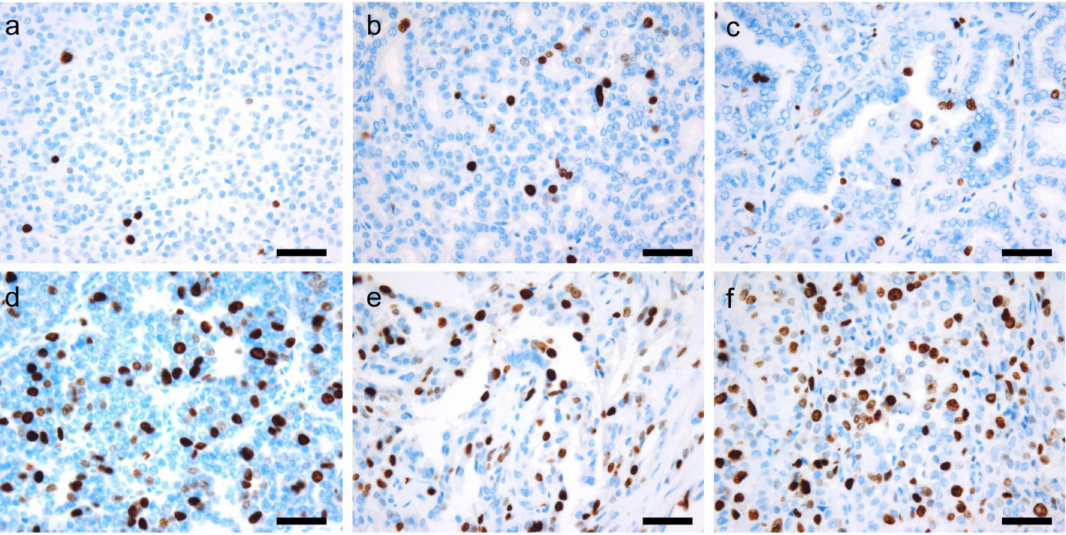
Figure 4. Immunohistochemical staining for Ki-67 in thyroid tumors. Different Ki-67 labeling indices are observed in follicular adenoma ( a , 2%), follicular thyroid carcinoma ( b , 4%), papillary thyroid car- cinoma ( c , 5%), poorly differentiated thyroid carcinoma ( d , 20%), and high-grade papillary thyroid car- cinoma ( e , 35%) coexisting with anaplastic thyroid carcinoma ( f , 40%). × 400 ( a – f ). Scale bar = 50 µ